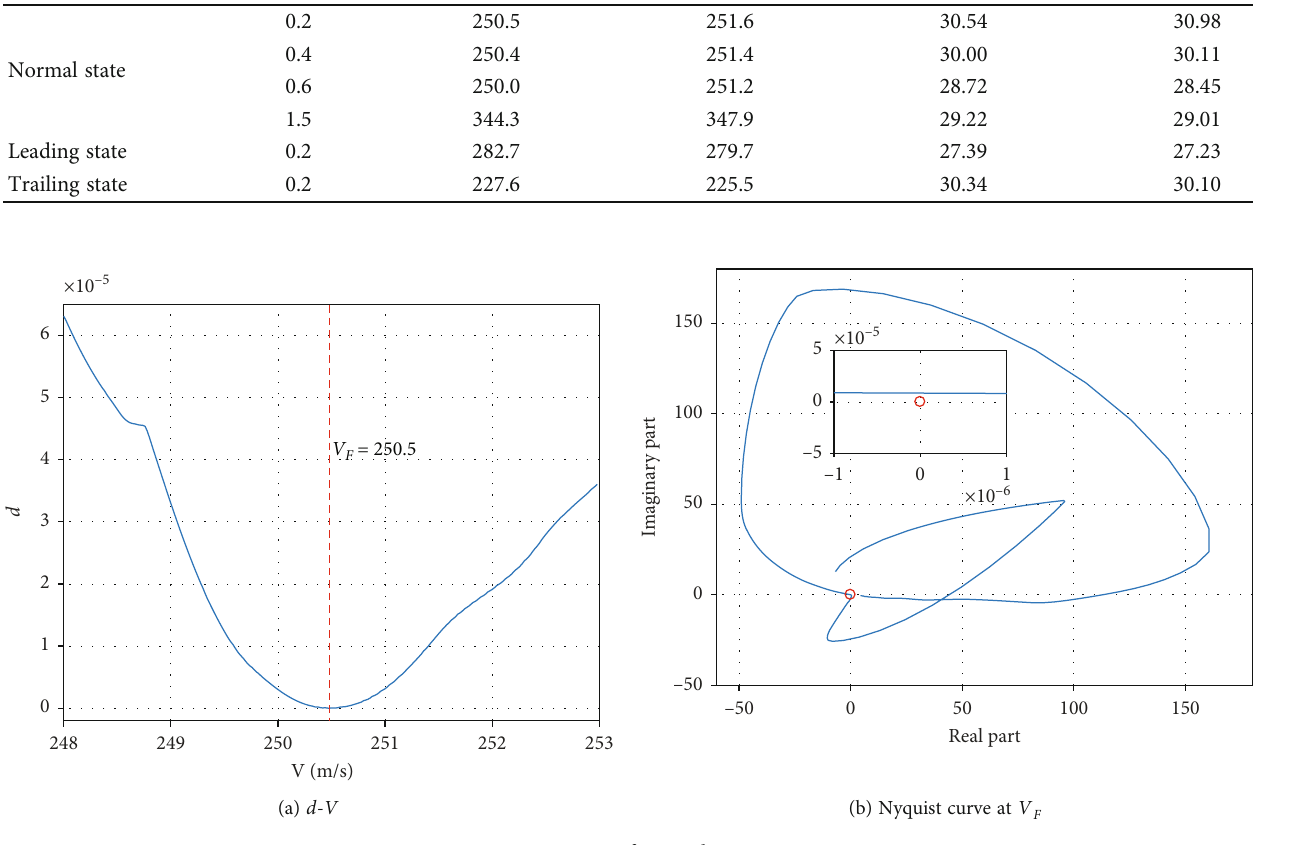
Figure 13: GFBP curves of normal state at Ma = 0 : 2 .